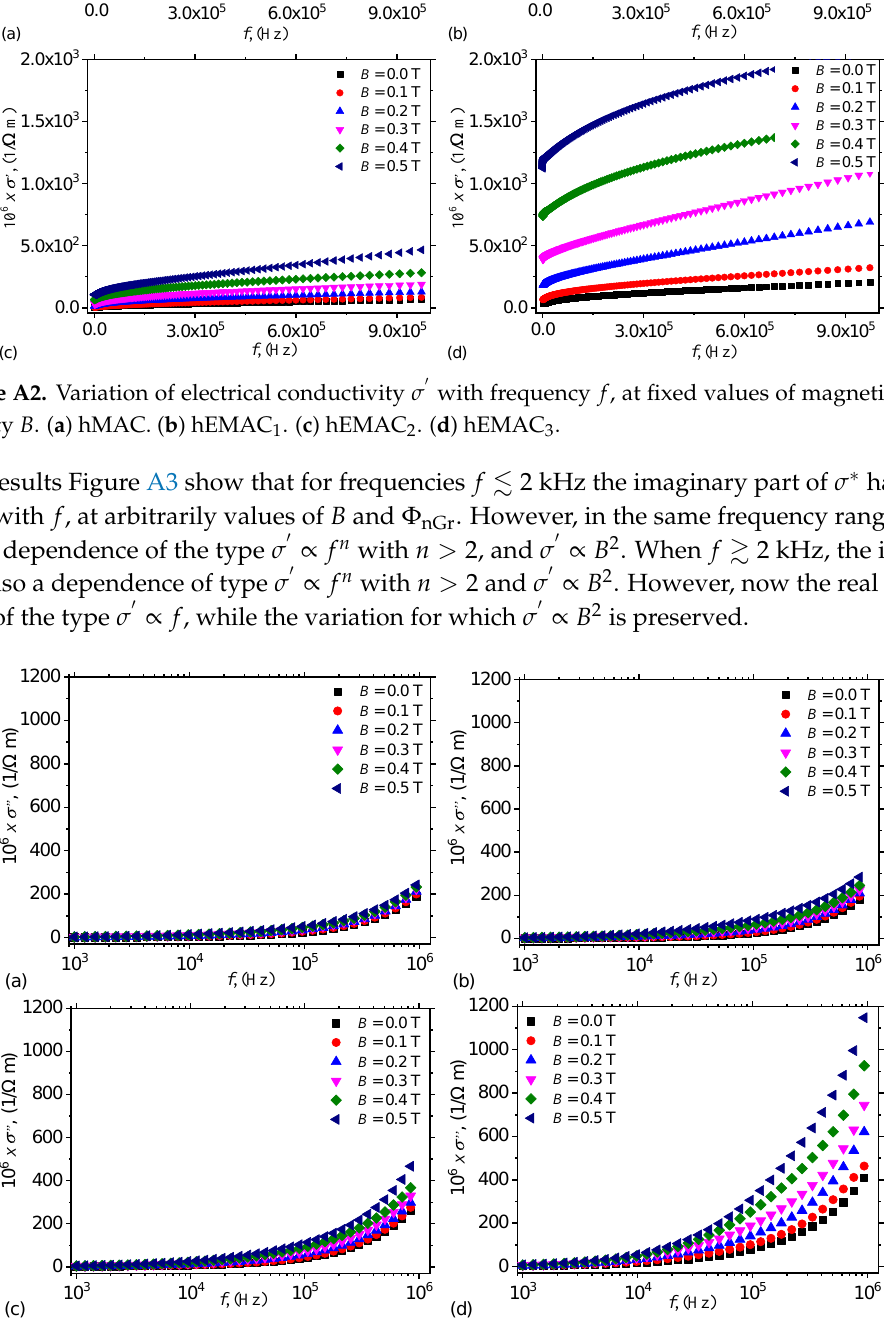
Figure A3. Variation of electrical conductivity σ (cid:48)(cid:48) with frequency f , at fixed values of magnetic flux density B . ( a ) hMAC. ( b ) hEMAC 1 . ( c ) hEMAC 2 . ( d ) hEMAC 3